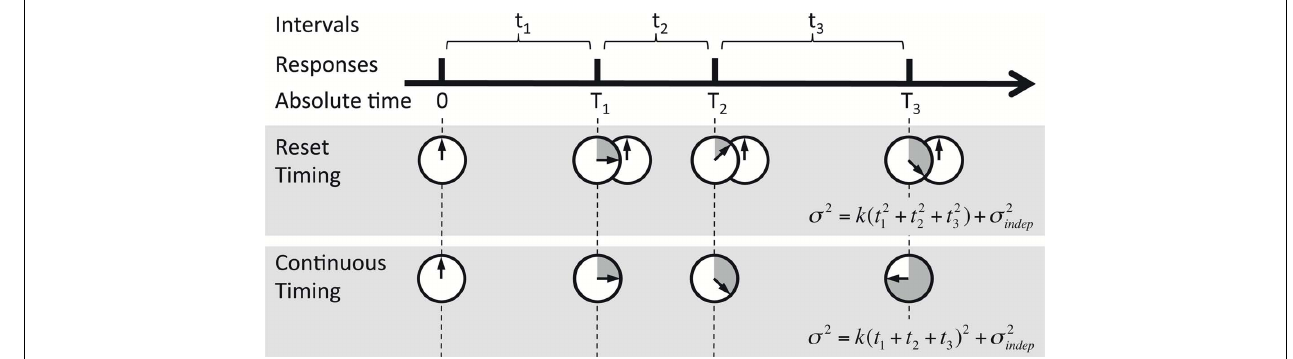
FIGURE 3 | Reset versus continuous timing. Timing of a temporal pattern (thick black line) could be achieved by timing every interval t n in isolation and resetting the timer at each response (Reset timing), or by timing continuously in absolute time T since the beginning of the pattern (Continuous timing).The